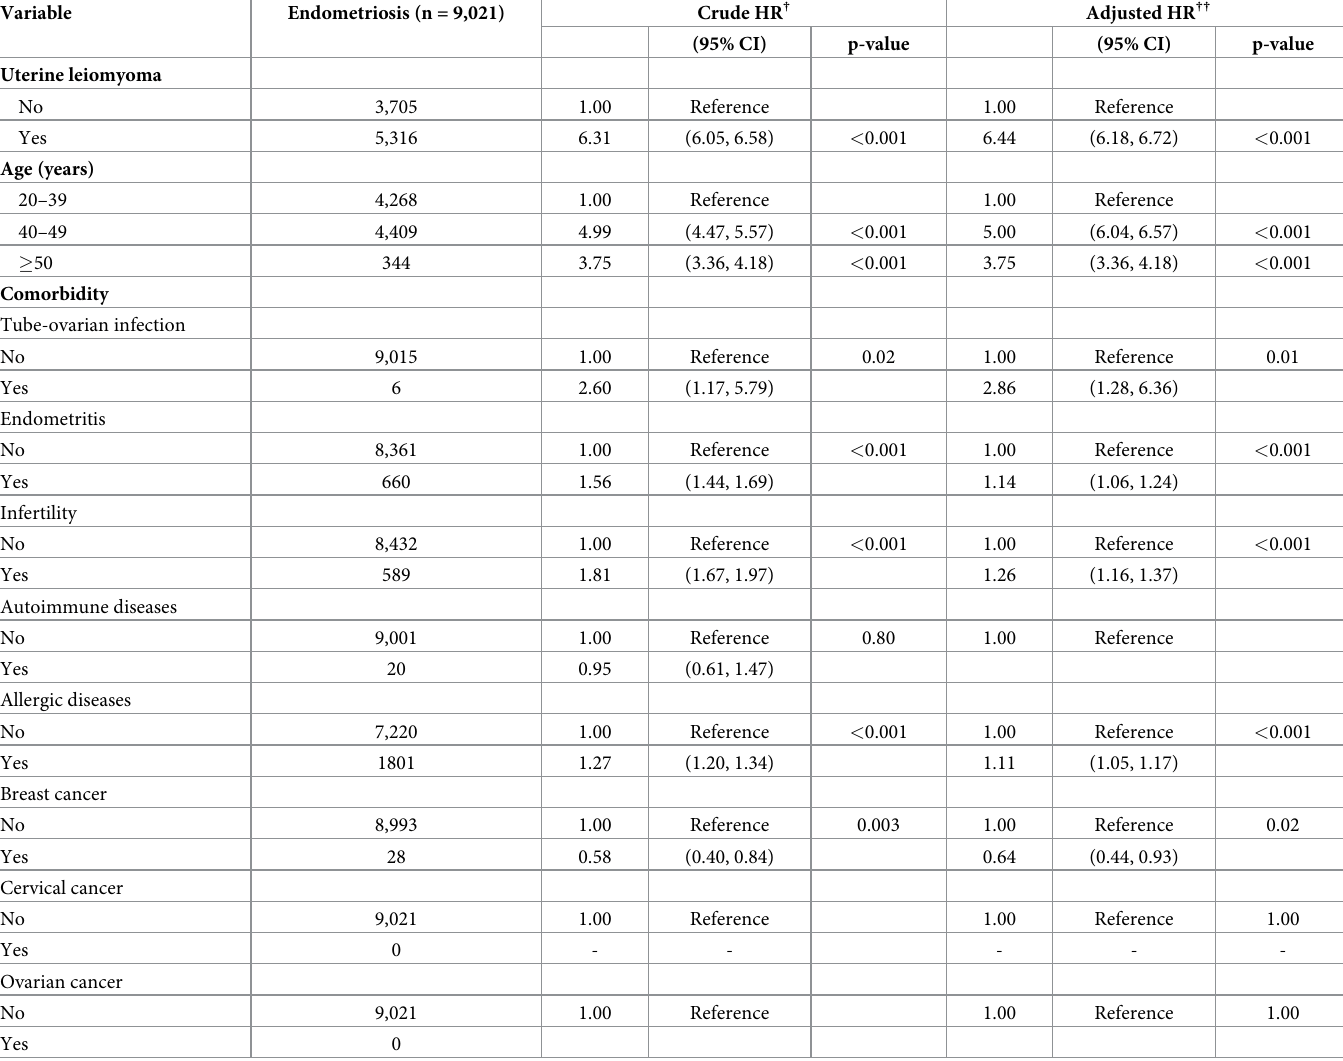
Table 2. Crude and adjusted risks of developing endometriosis associated with uterine leiomyoma.